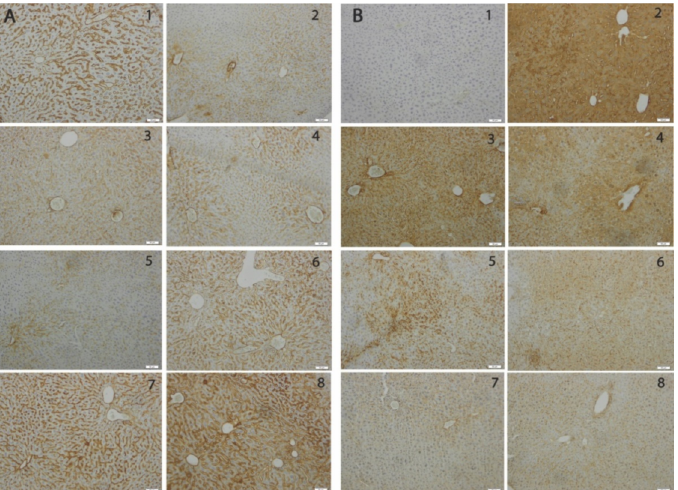
Figure 7. Hepatic immunohistochemical expression of bcl-2 ( A ) and bax ( B ) in: 1—control; 2—CdCl 2 ; 3—CdCl 2 + 0.1 mg/kg SeNPs; 4—CdCl 2 + 0.2 mg/kg SeNPs; 5—CdCl 2 + 0.4 mg/kg SeNPs; 6—CdCl 2